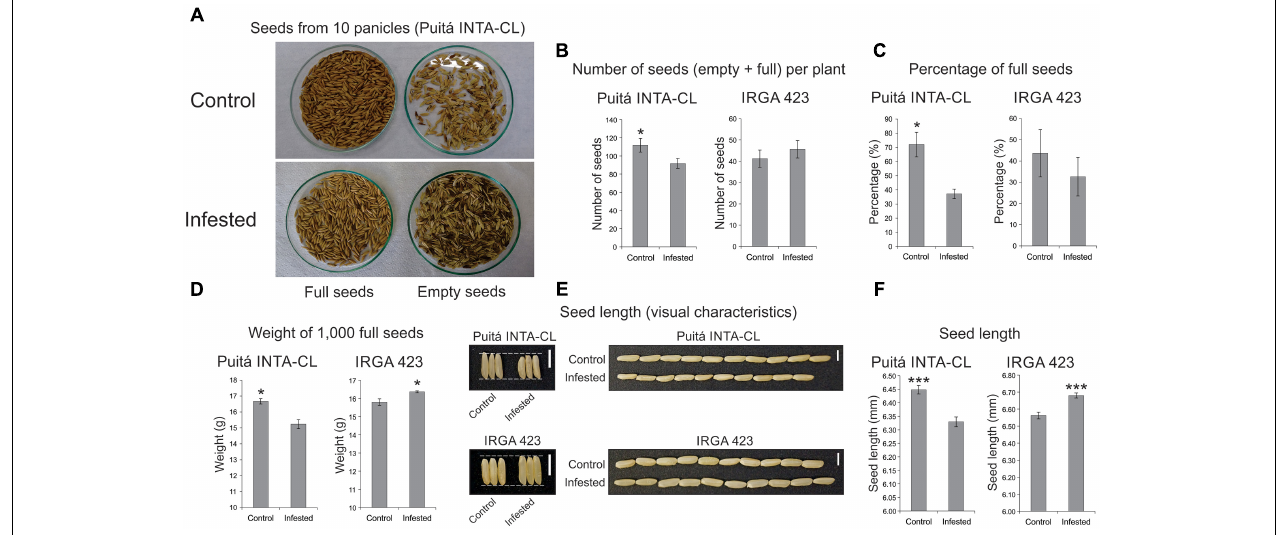
FIGURE 4 | Seeds analysis of the two tested cultivars (Puitá INTA-CL and IRGA 423). (A,B) Number of seeds (empty + full) per plant. (C) Percentage of full seeds. (D) Weight of 1,000 full seeds. (E) Seed length (visual characteristics). (F) Seed length (mm). Represented values are the averages of 50 samples ± SE. Mean values with one or three asterisks are significantly different as determined by the Student’s t -test ( P ≤ 0.05 and 0.001). Bars in panel (E) indicate 0.5 cm.